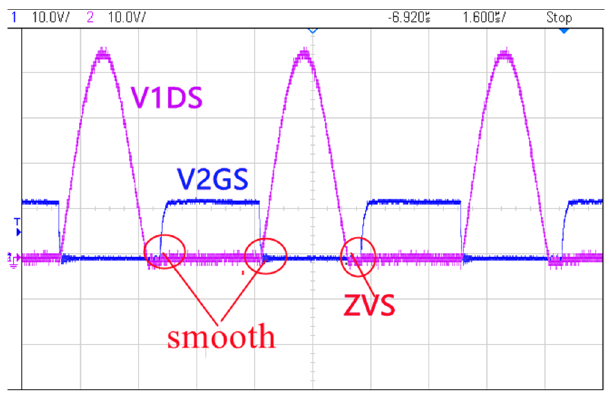
Figure 22. IDC soft switch waveforms.